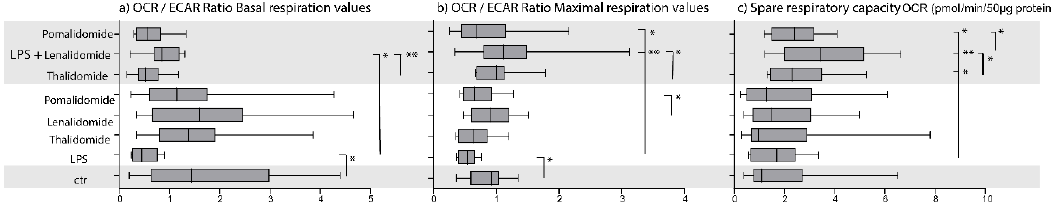
Figure 1. Analysis of monocyte metabolism using the XF Mito Stress Test assay and the Seahorse XF 96 cell analyzer; a summary of the overall results. Normal monocytes were cultured in medium alone or in the presence of LPS (lipopolysaccharide) 1 ng/mL, or IMiDs (immunomodulatory drugs) 5 μ g/mL for four hours before the oxygen consumption rate (OCR) and extracellular acidification rate (ECAR) were determined. Each of the figures presents the OCR:ECAR ratio (diagrams ( a , b )) or the spare respiratory capacity (diagram ( c )) for cultures prepared in (from the bottom to the top of each diagram) (i) medium alone (ctr), (ii) LPS control, (iii) each of the IMiDs—thalidomide, lenalidomide, or pomalidomide—in medium alone without LPS; and (iv) LPS in combination with either thalidomide, lenalidomide or pomalidomide. The figures show the results for ( a ) the OCR:ECAR ratio during the initial period of basal incubation; ( b ) the period of maximal respiration after addition of FCCP (Carbonyl cyanide-4 (trifluoromethoxy) phenylhydrazone; an uncoupling agent); and ( c ) the calculated spare respiratory capacity. The figure summarizes the results for 10 independent experiments testing monocytes from 10 healthy blood donors. The results are presented as median, box (i.e., the 25–75 percentiles) and whiskers (the 5–95 percentiles). The Wilcoxon test for paired samples was used for the statistical comparisons, and p -values < 0.05 were regarded as statistically significant. The significant comparisons are indicated in the figure (* p < 0.05, ** p < 0.01).